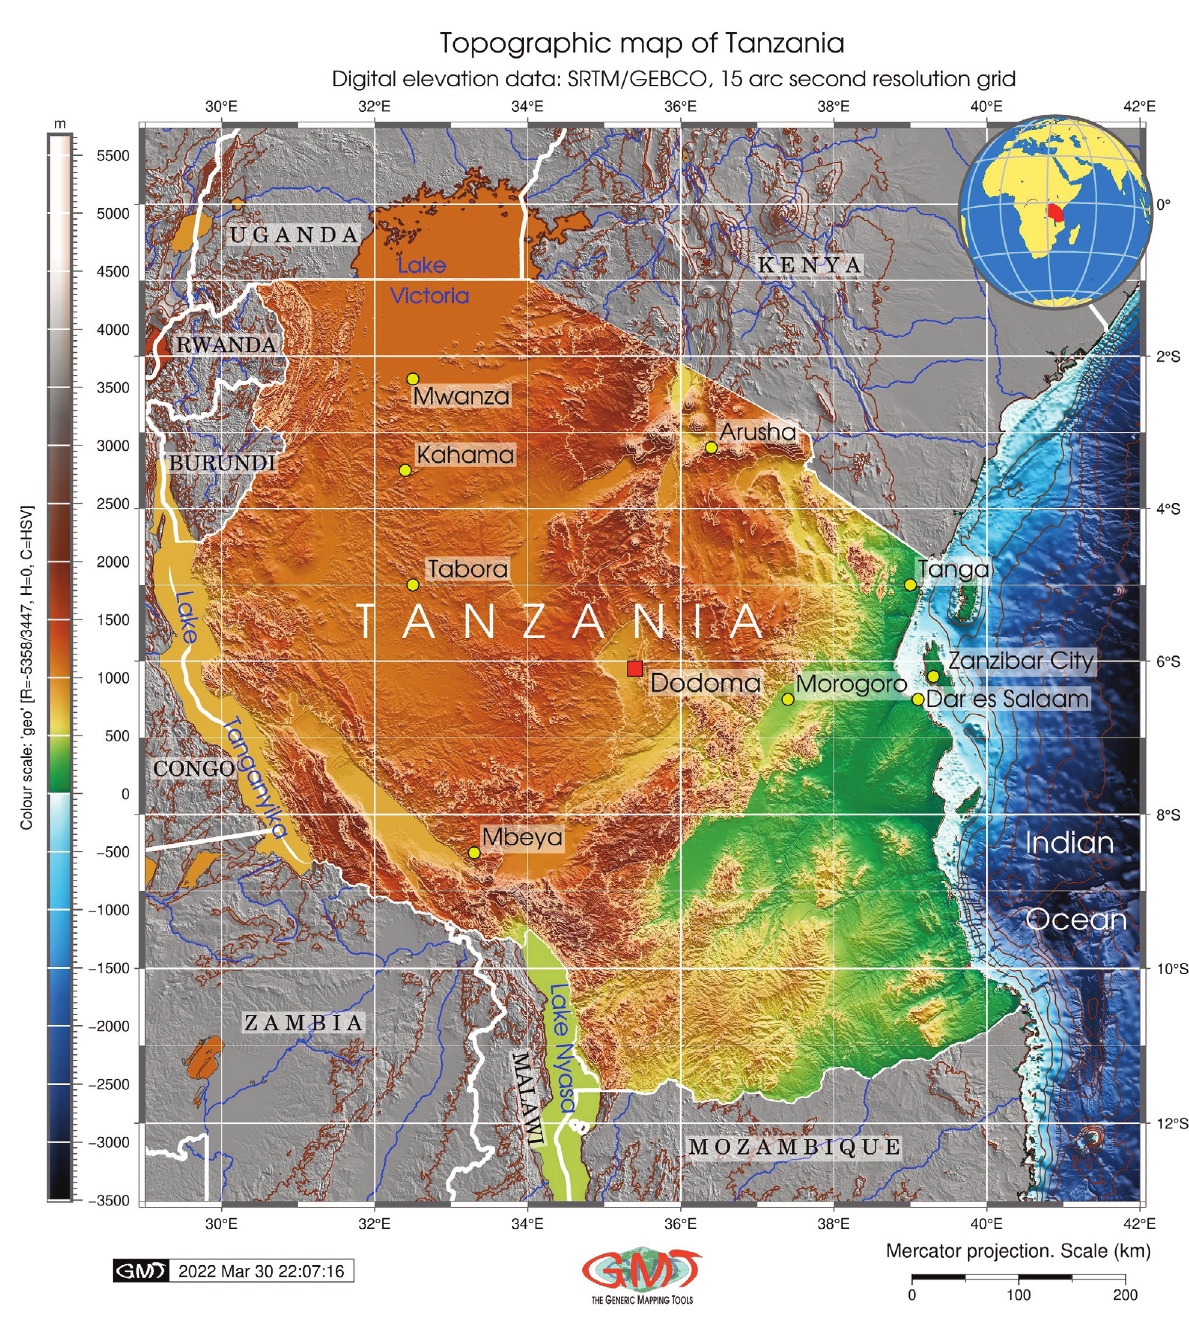
Fig. 1. Topographic map of Tanzania. Data: General Bathymetric Chart of the Oceans (GEBCO) overprinted on the monochrome shadow Digital Elevation Model (DEM) image. Data source: GEBCO Compilation Group 2020. Map source: elaborated by